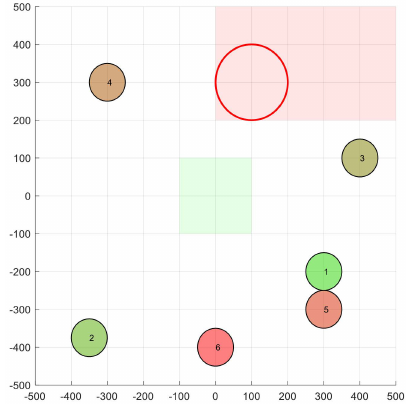
Figure 3. Velocity obstacle (VO) produced by node 3 in node 1.